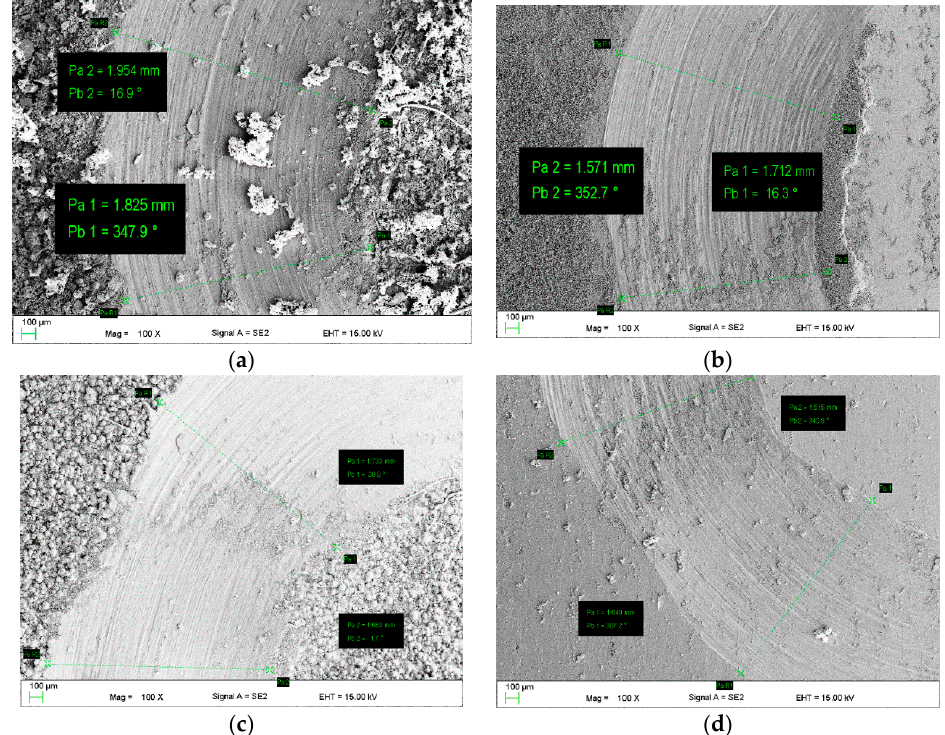
Figure 26. The surface of Ti solid 4 ( a , b ) and Ti solid 8 ( c , d ) specimens after tribological examination: ( a,c ) specimen side and ( b,d ) specimen